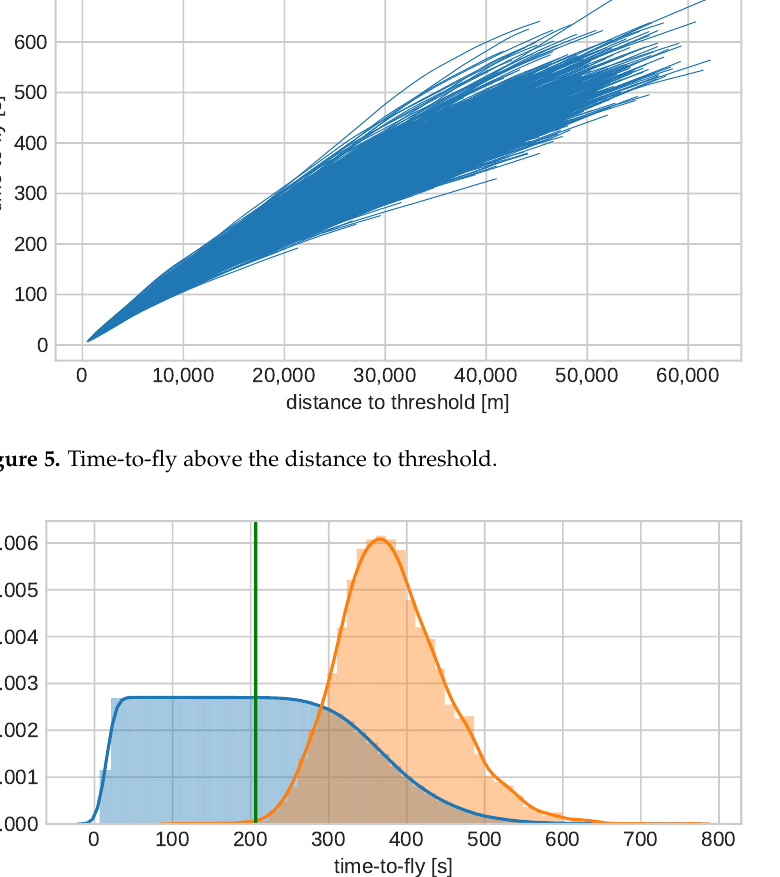
Figure 6. Distribution of time-to-fly values. The blue histogram comprises the full data set. The or- ange one depicts the time-to-fly at first entry of an aircraft. Solid curves depict the kernel density estimation. The green line depicts the mean over all time-to-fly